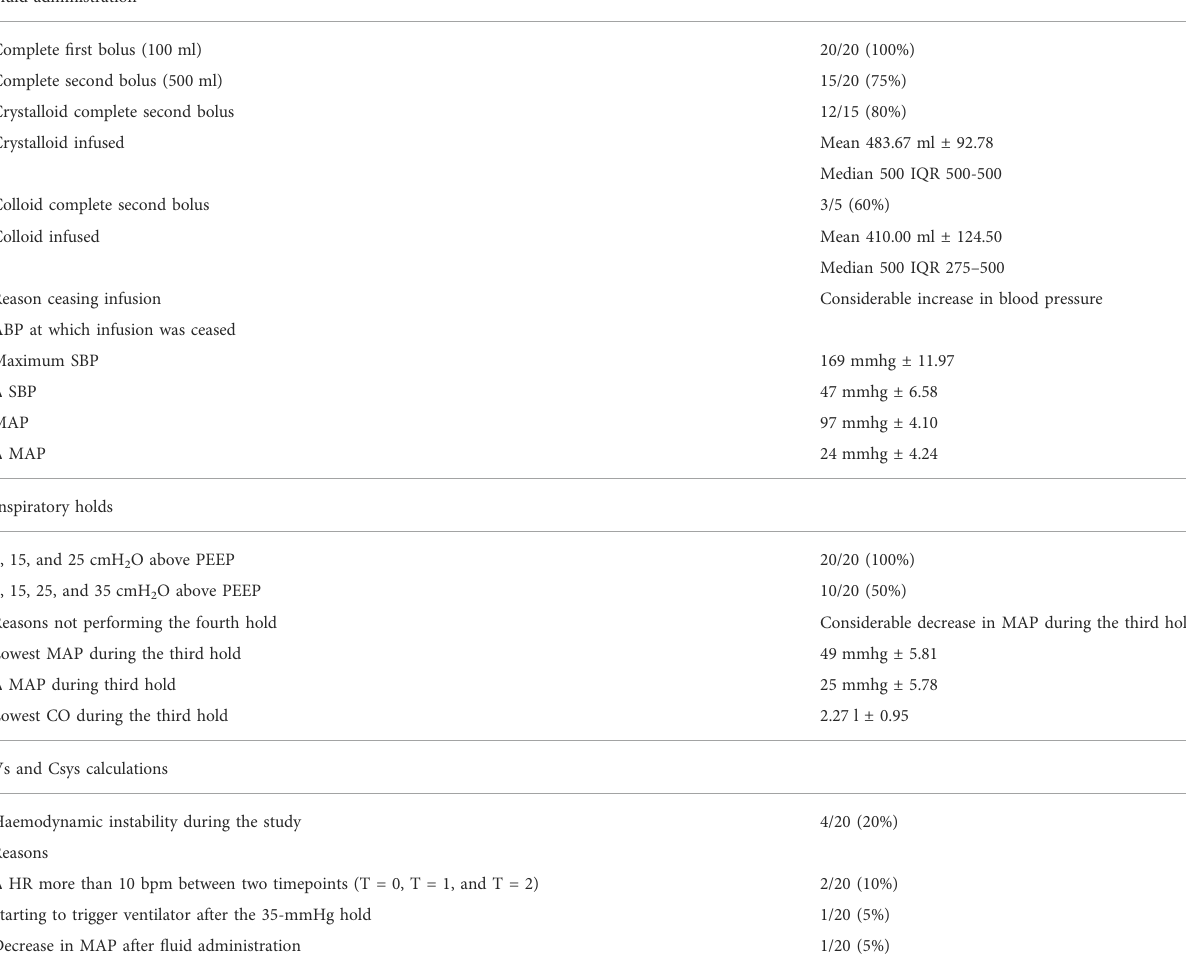
TABLE 3 Protocol deviations +